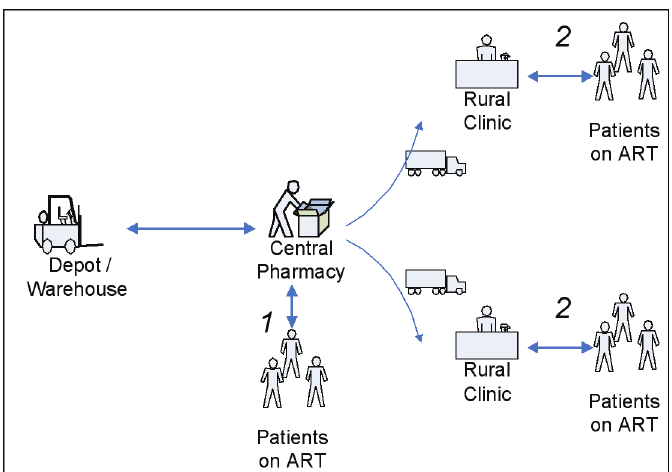
Figure 2: iDART set-up allowing for two types of ARV dispensing. Direct dispensing occurs when patients collect their medication from the pharmacy directly (1 in figure). Remote dispensing by down-referral occurs when patients collect their pre-packaged ARV medication from remote clinics, situated in communities (2 in figure). (Brown et al.